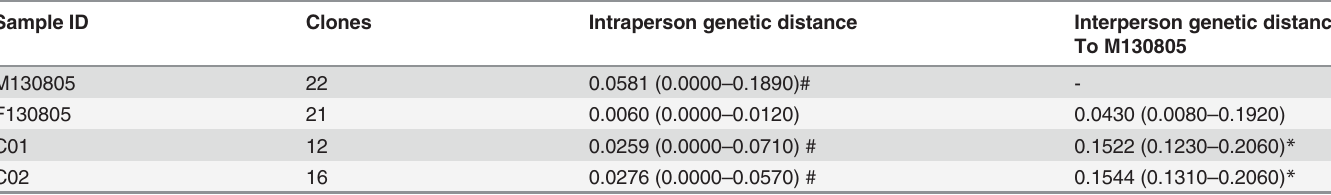
Table 3. The genetic distances of env quasispecies. Sample